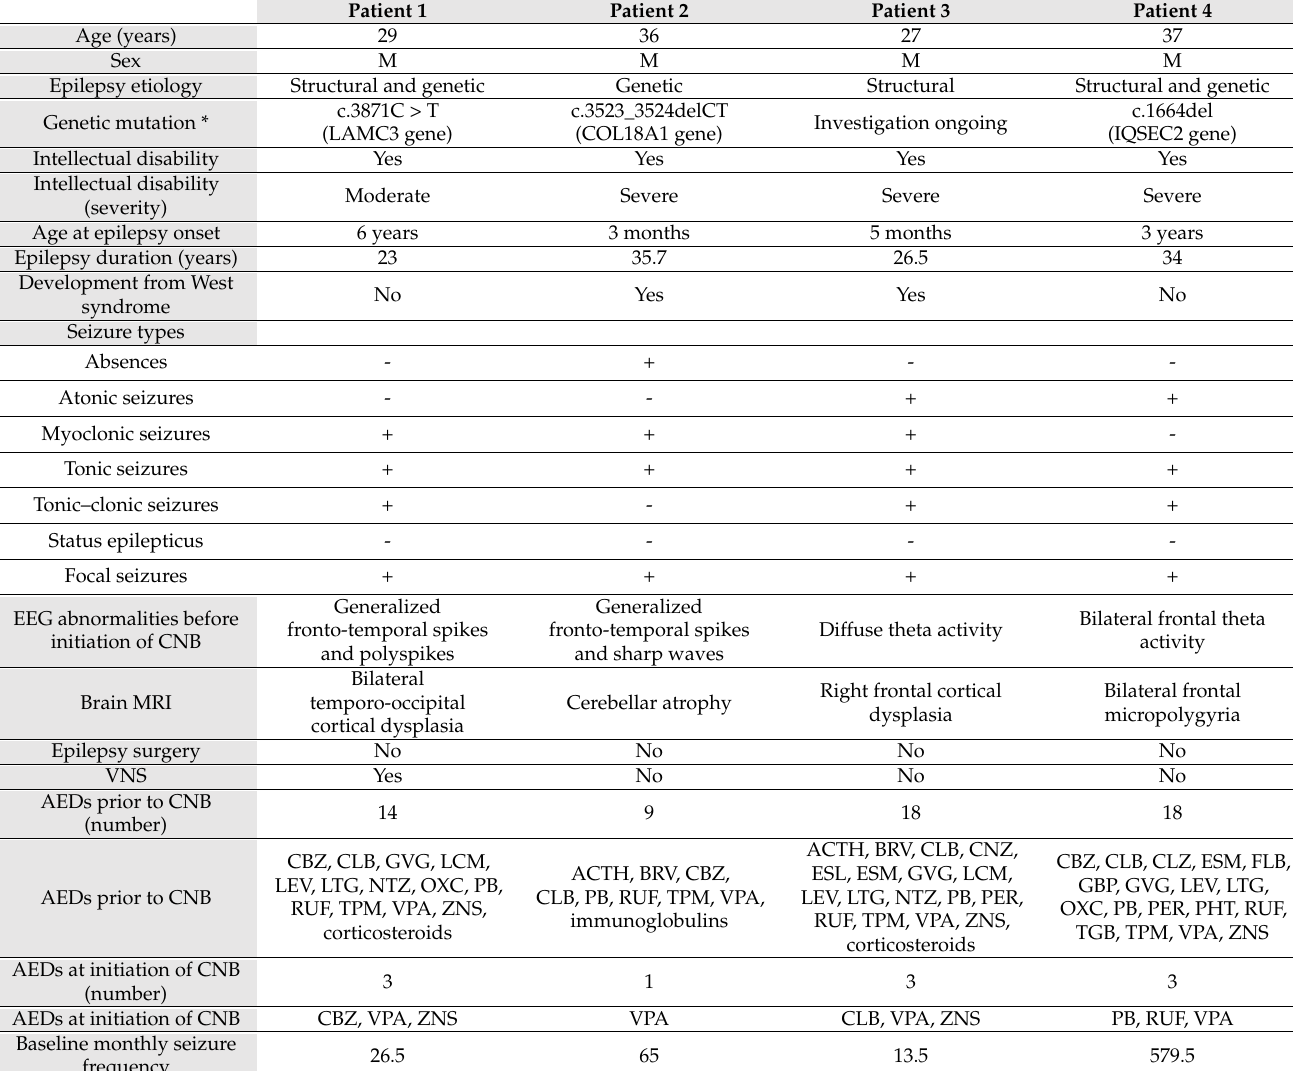
Table 1. Baseline characteristics of the